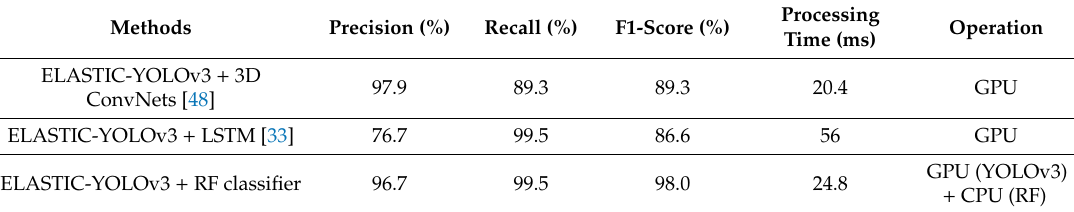
Table 4. Comparison of the precision, recall, F1-score, and processing time of four comparison methods using the NightFire-DB. The processing time of each algorithm included 15 ms of ELASTIC-YOLOv3.